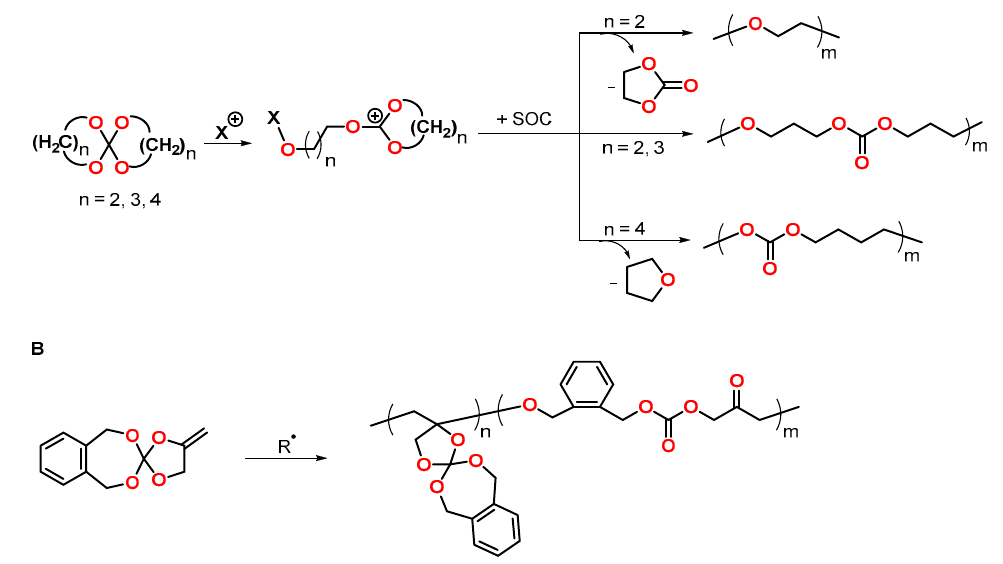
Figure 14. ( A ): Schematic representation of the cationic ring-opening polymerization of SOCs. ( B ): Schematic representation of the radical polymerization of SOCs bearing exo -methylene groups.